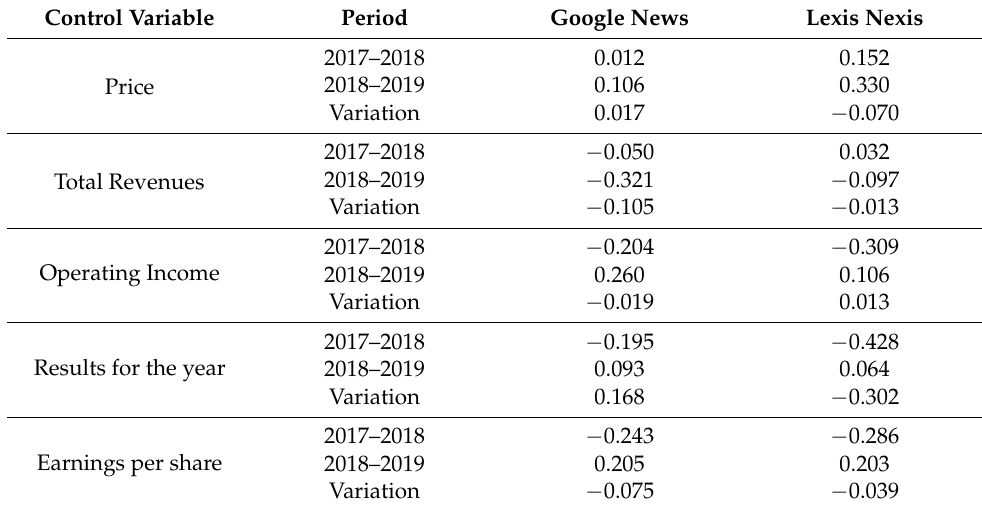
Table 4. Correlations between legitimacy and control